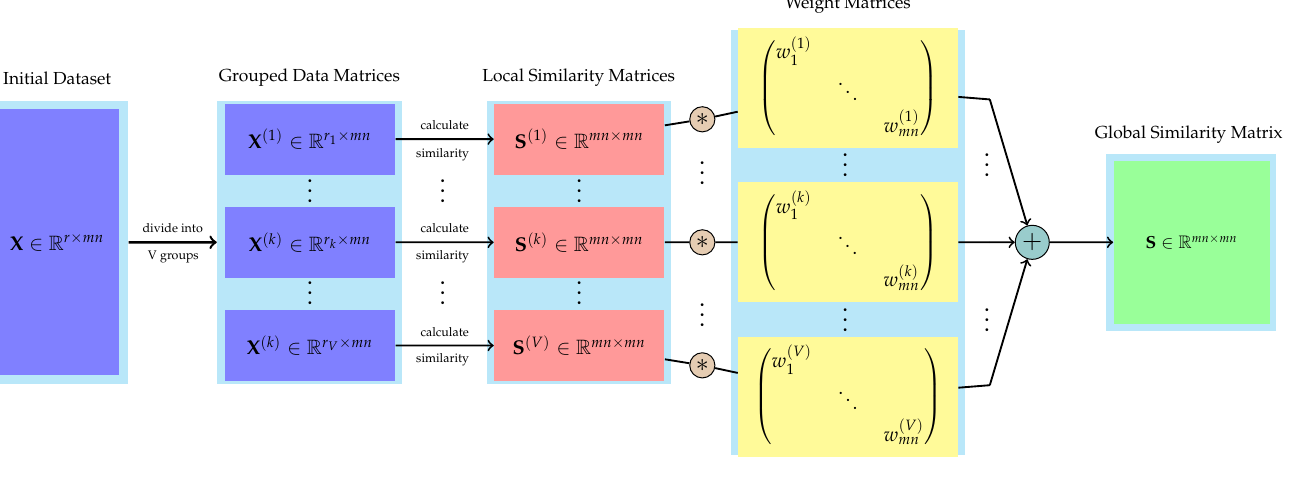
Figure 1. The workflow of the idea of band grouping of the global similarity matrix reconstructed by the local similarity